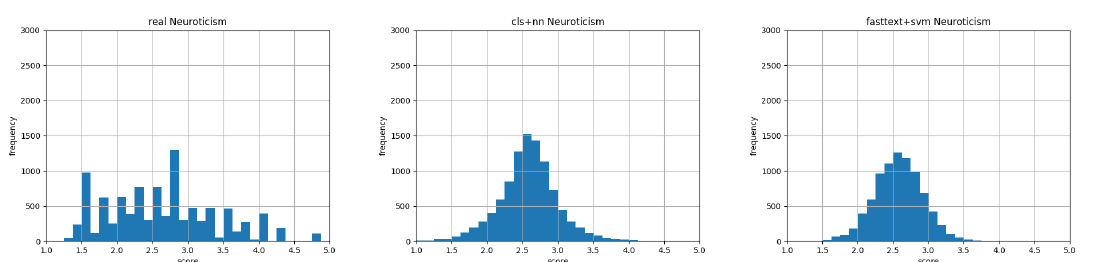
Figure 10. Neuroticism: Histograms representing data distribution of gold standard on the left, our model result in the middle, and previous state of the art by Carducci et al. [8] on the